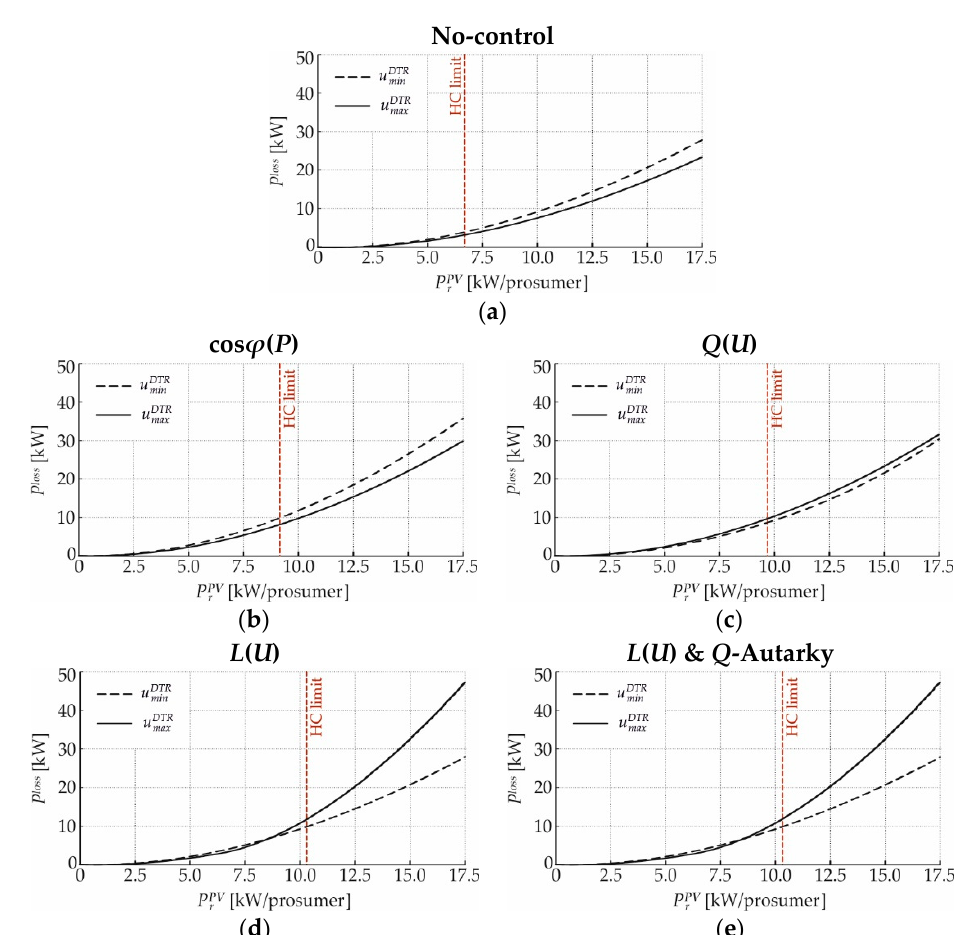
Figure 14. Grid losses of the short cable test-feeder for the minimal and maximal DTR primary voltages and different control strategies: ( a ) no-control; ( b ) cos φ ( P )-control; ( c ) Q ( U )-control; ( d ) L ( U )-control; ( e ) L ( U )-control and Q -Autarkic prosumers.